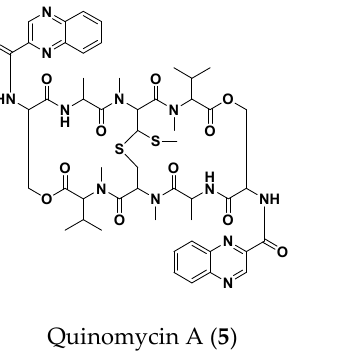
Figure 4 . Structures of microbial anti-non-tuberculous mycobacteria (NTM) compounds. Figure 4. Structures of microbial anti-non-tuberculous mycobacteria (NTM) compounds. Table 1. MIC values of anti-NTM agents against four Table 1. MIC values of anti-NTM agents against four mycobacteria.